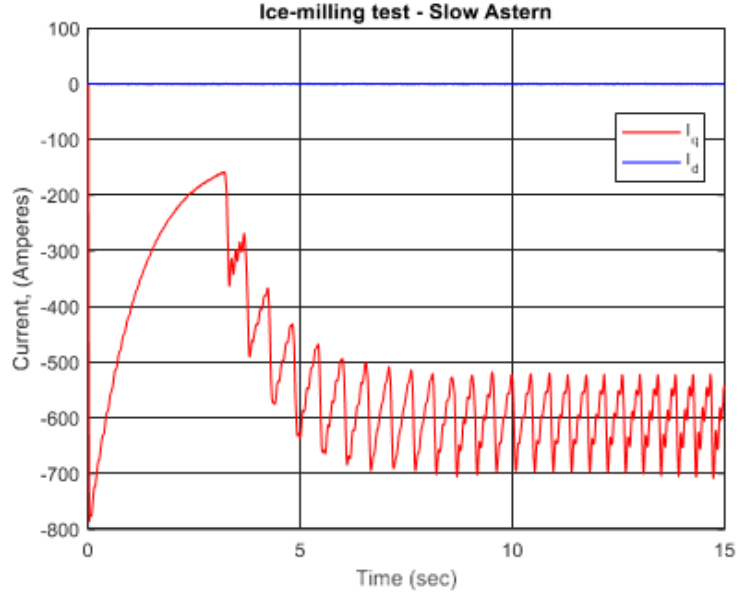
Figure 17. Ice milling motor dq currents.